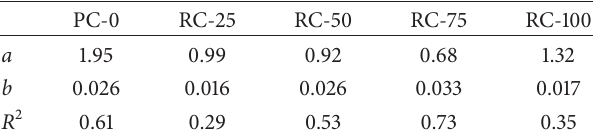
Table 4: Parameters in (4) for RAC specimens.